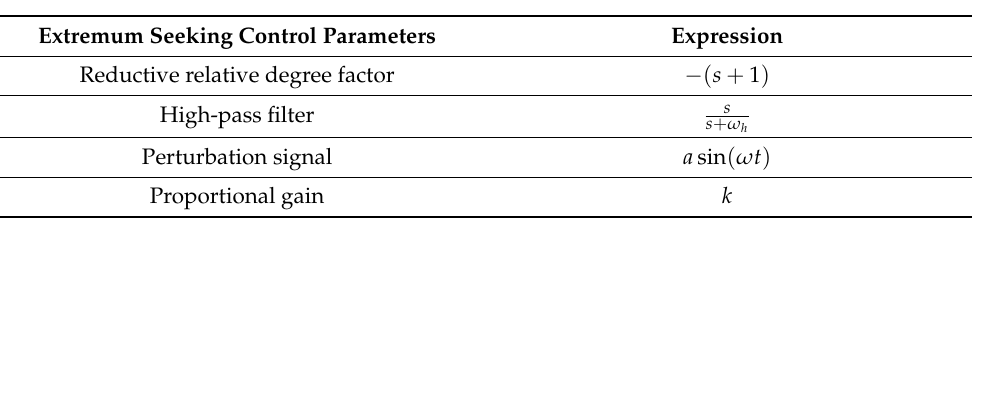
Table 1. Extremum seeking control parameters and system